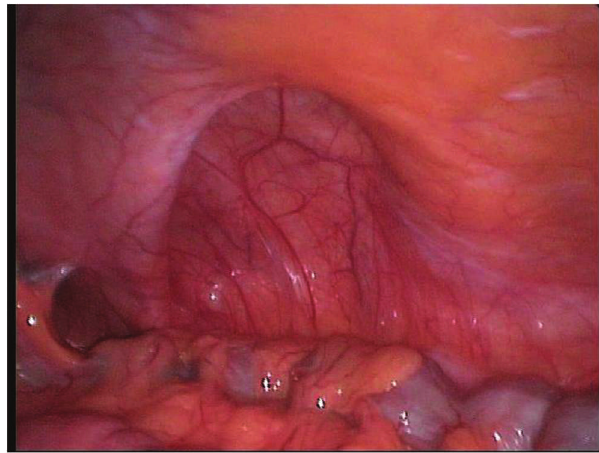
Figure 2 - Exposure of the entire hernia ring.